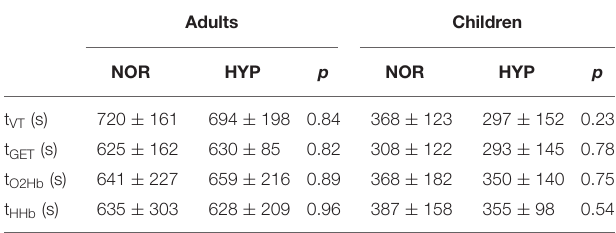
TABLE 2 | Ventilatory and gas-exchange thresholds presented as time intervals from beginning of exercise to the moment of occurrence of particular threshold obtained during the graded cycling exercise test in adults and children.